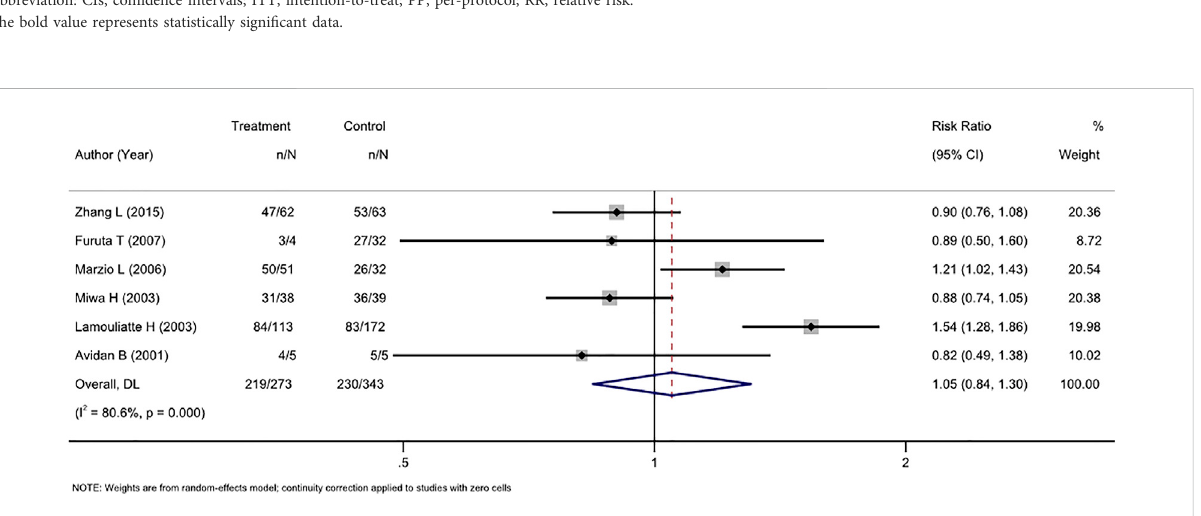
FIGURE 3 Forest plot of the ITT ef fi cacy of RCTs comparing tailored treatment with empirical treatment in the second-line